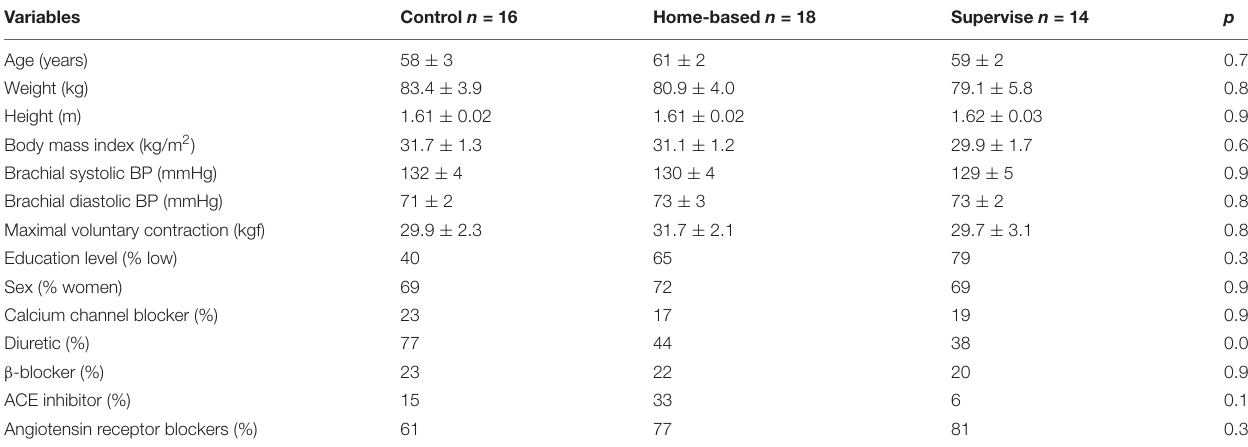
TABLE 1 | General characteristics of experimental groups at